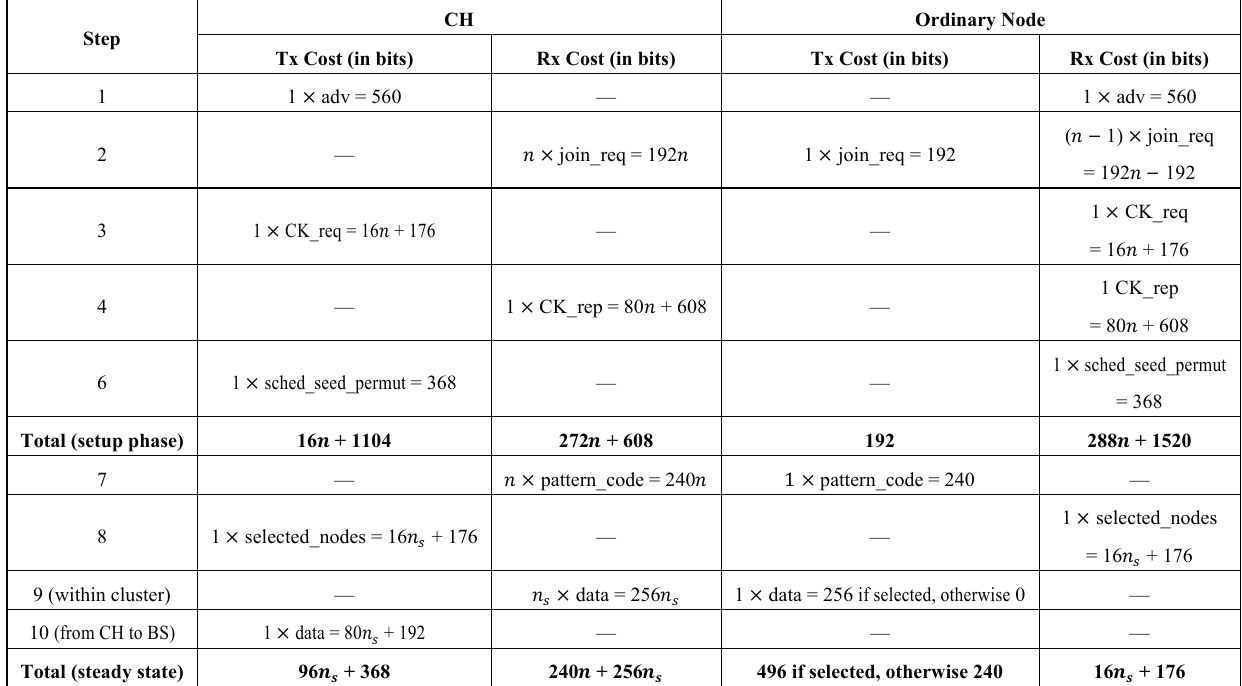
Table 12. Communication cost of the proposed protocol in setup phase and steady state